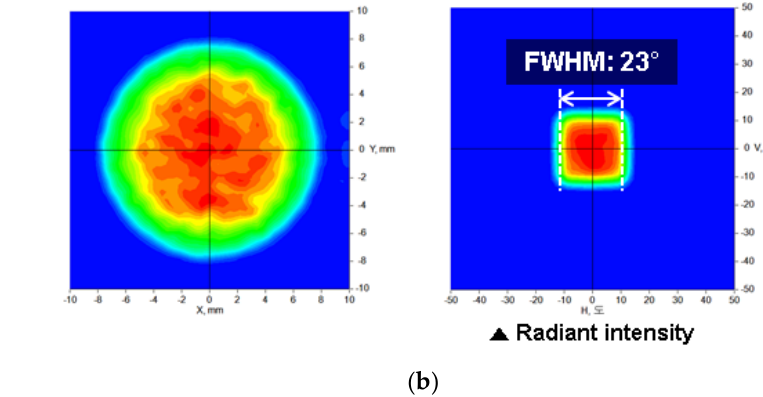
Figure 10. Simulation characteristics using a two-stage plano-convex lens: ( a ) improved ray path characteristics; ( b ) improved beam profile and light distribution characteristics.